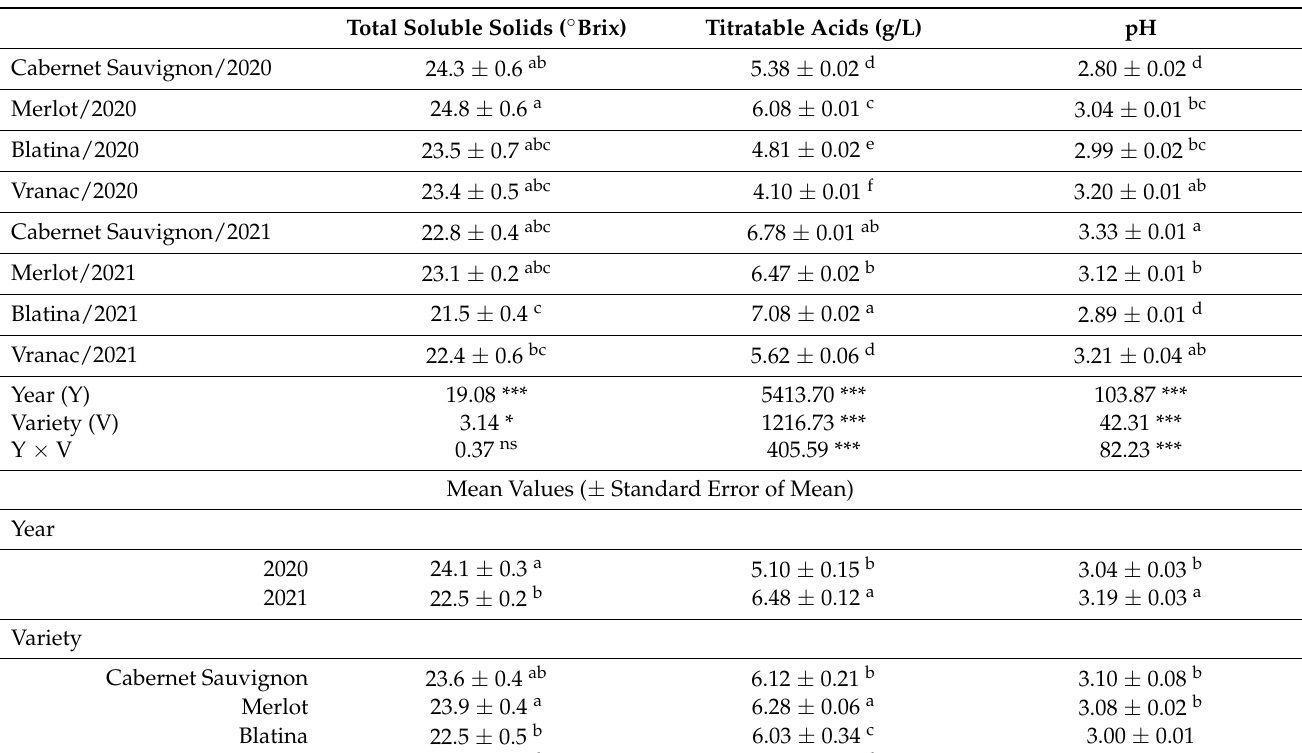
Table 5. Grape quality of the analyzed varieties during the research period at Trebinje locality. Total Soluble Solids ( ◦ Brix) Titratable Acids (g/L)